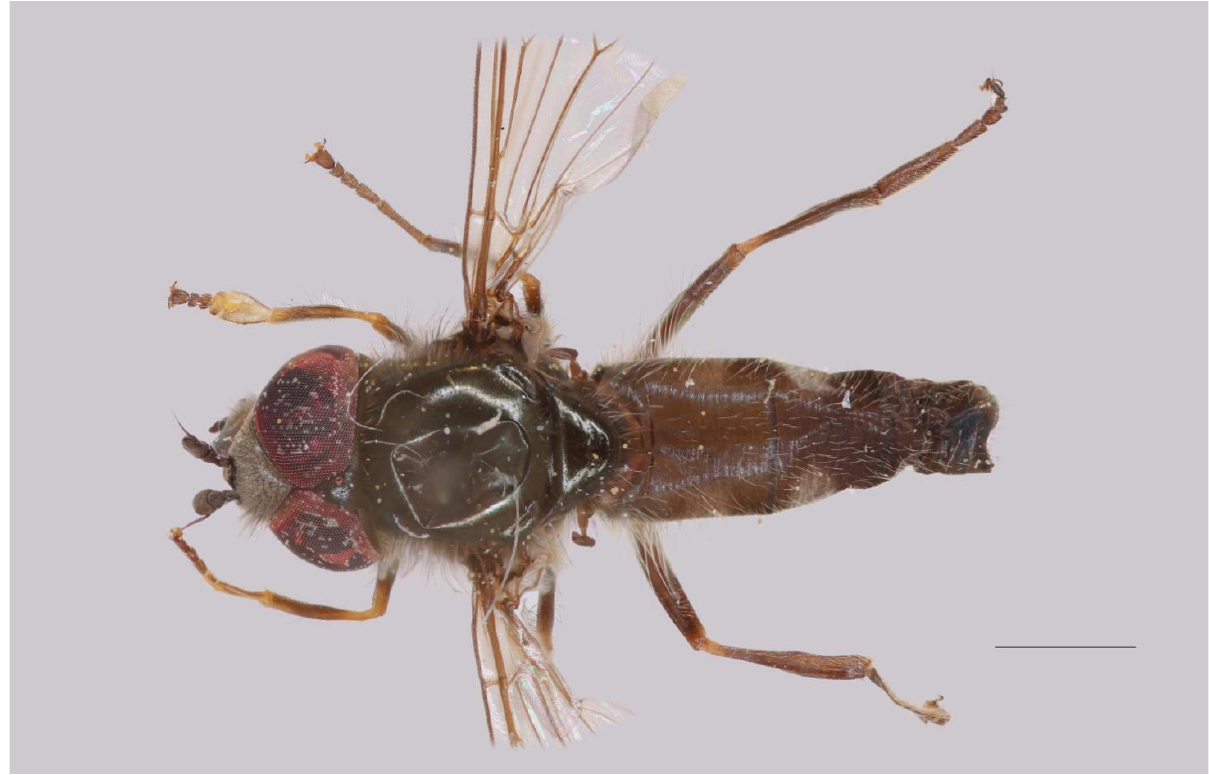
Figure 6. Adult male habitus, dorsal view Platycheirus torei , Seitajaure, Sweden. Scale bar 1.0